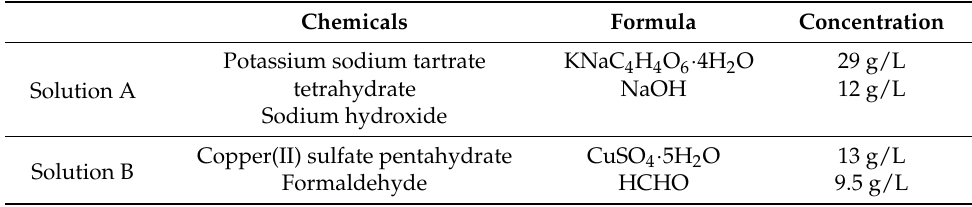
Table 3. Chemicals used for